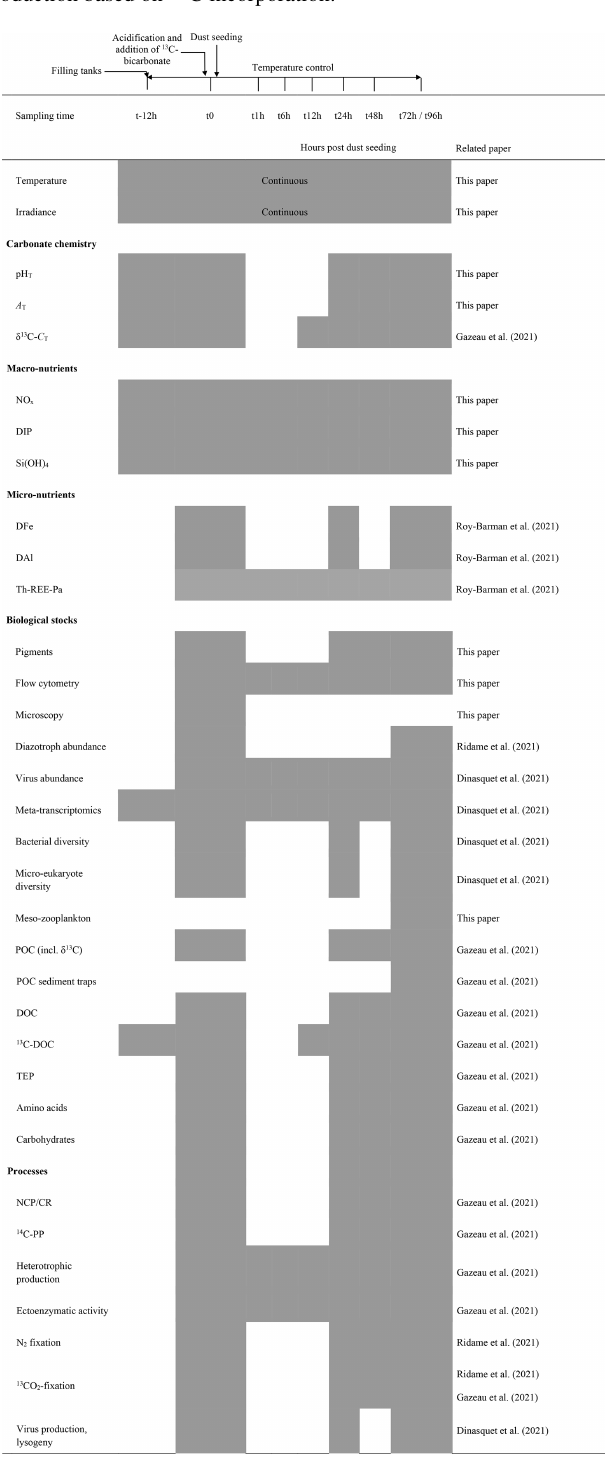
Table 1. List of parameters and processes investigated during the three experiments at stations TYR, ION and FAST. Corresponding papers are indicated. pH T : pH on the total scale, A T : total alkalinity, 13 C-C T : 13 C signature of dissolved inorganic carbon, NO x : nitrate + nitrite, DIP: dissolved inorganic phosphorus, Si(OH) 4 : silicate, DFe: dissolved iron, DAl: dissolved aluminium, Th-REE-Pa: thorium ( 230 Th and 232 Th), rare earth elements and protactinium ( 231 Pa), POC: particulate organic carbon, DOC: dissolved organic carbon, 13 C-DOC: 13 C sig- nature of dissolved organic carbon, TEP: transparent exopolymer particles, NCP/CR: net community production and community respiration (oxygen based), 14 C-PP: primary production based on 14 C